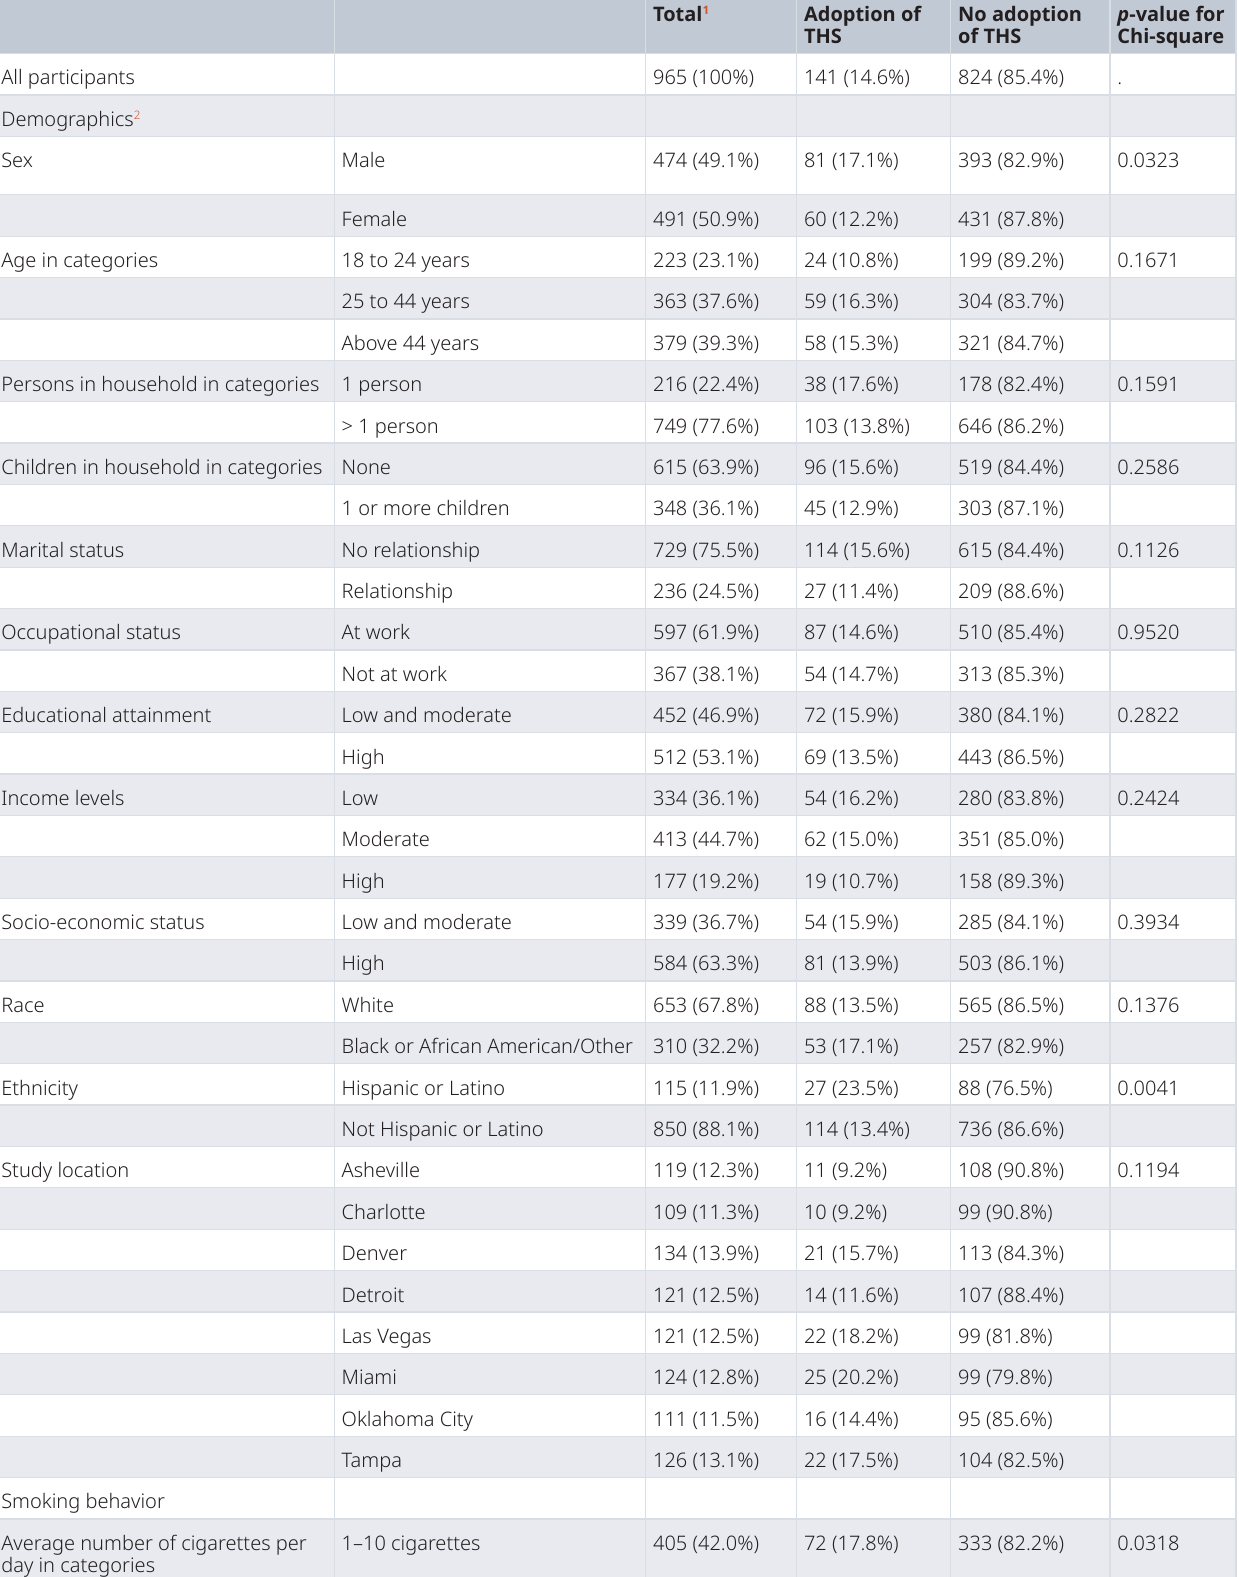
Table 1. Demographic characteristics and potential predictors by adoption of THS at the end of the observational period.